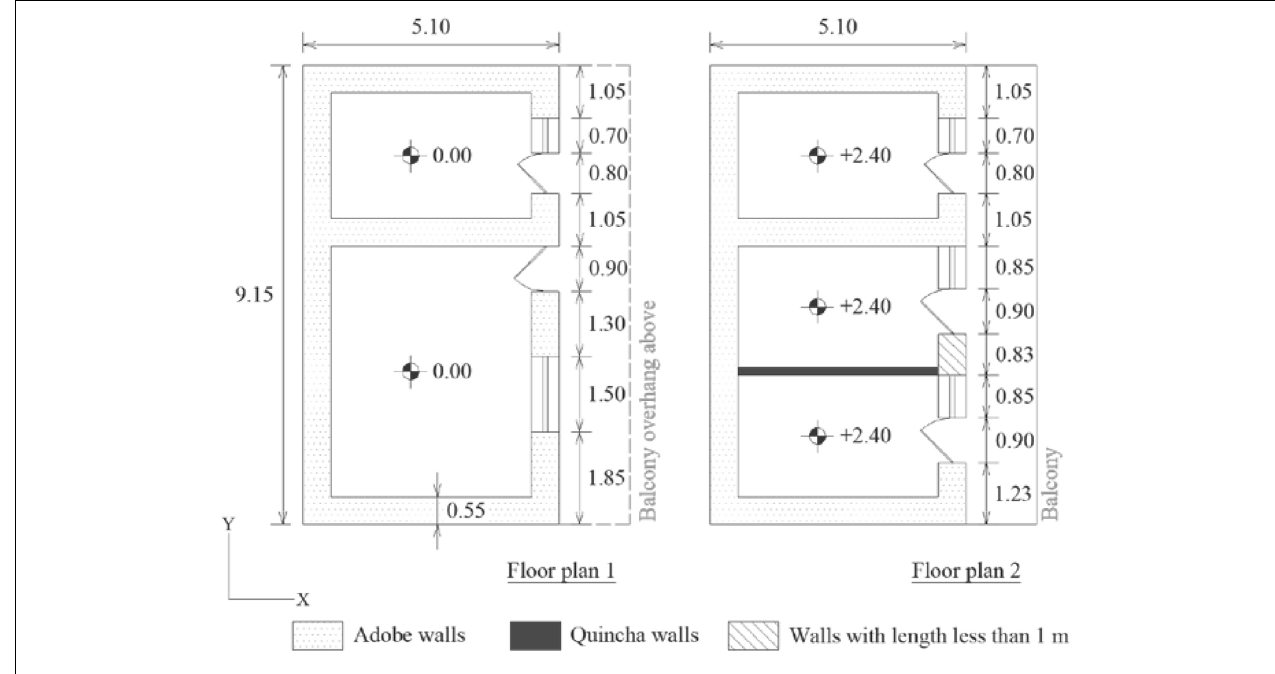
FIGURE 3 | Plan view of the two-story adobe